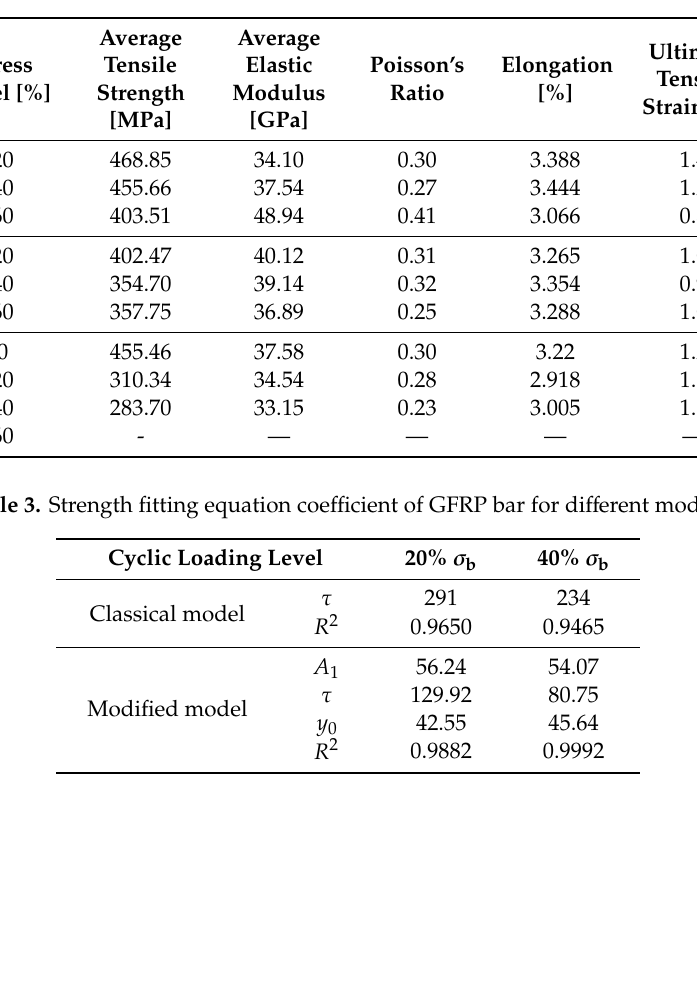
Table 2. Mechanical properties of GFRP bars under loading and in alkaline solution.